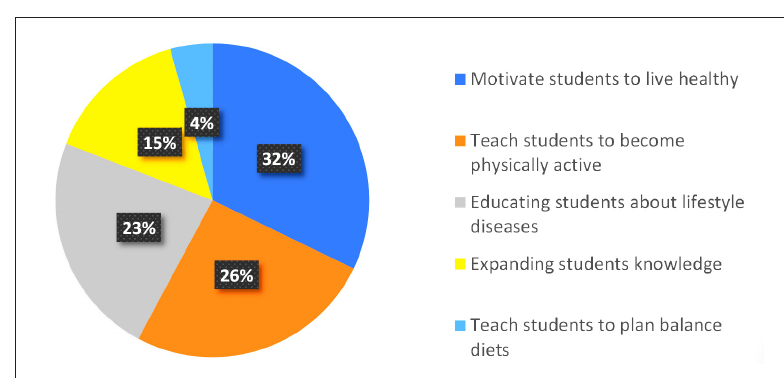
Figure 3. PE teachers perceive their roles